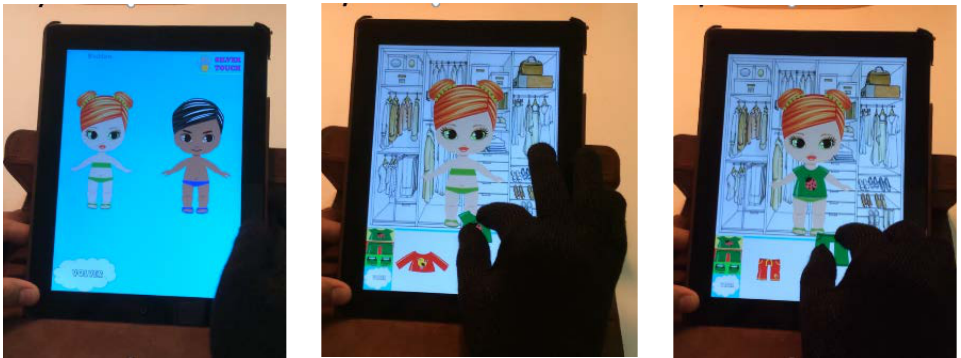
Figure 2. Dress the